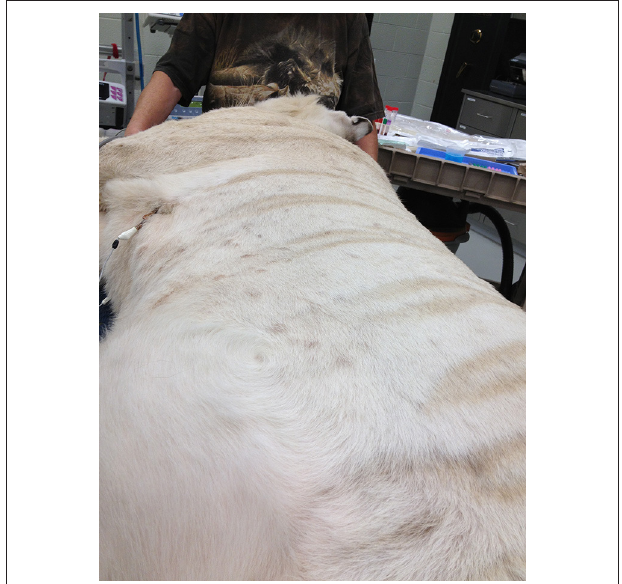
FIGURE 13 | Urticaria in a white tiger noted at the end of the MRI examination and attributed to a reaction to contrast medium